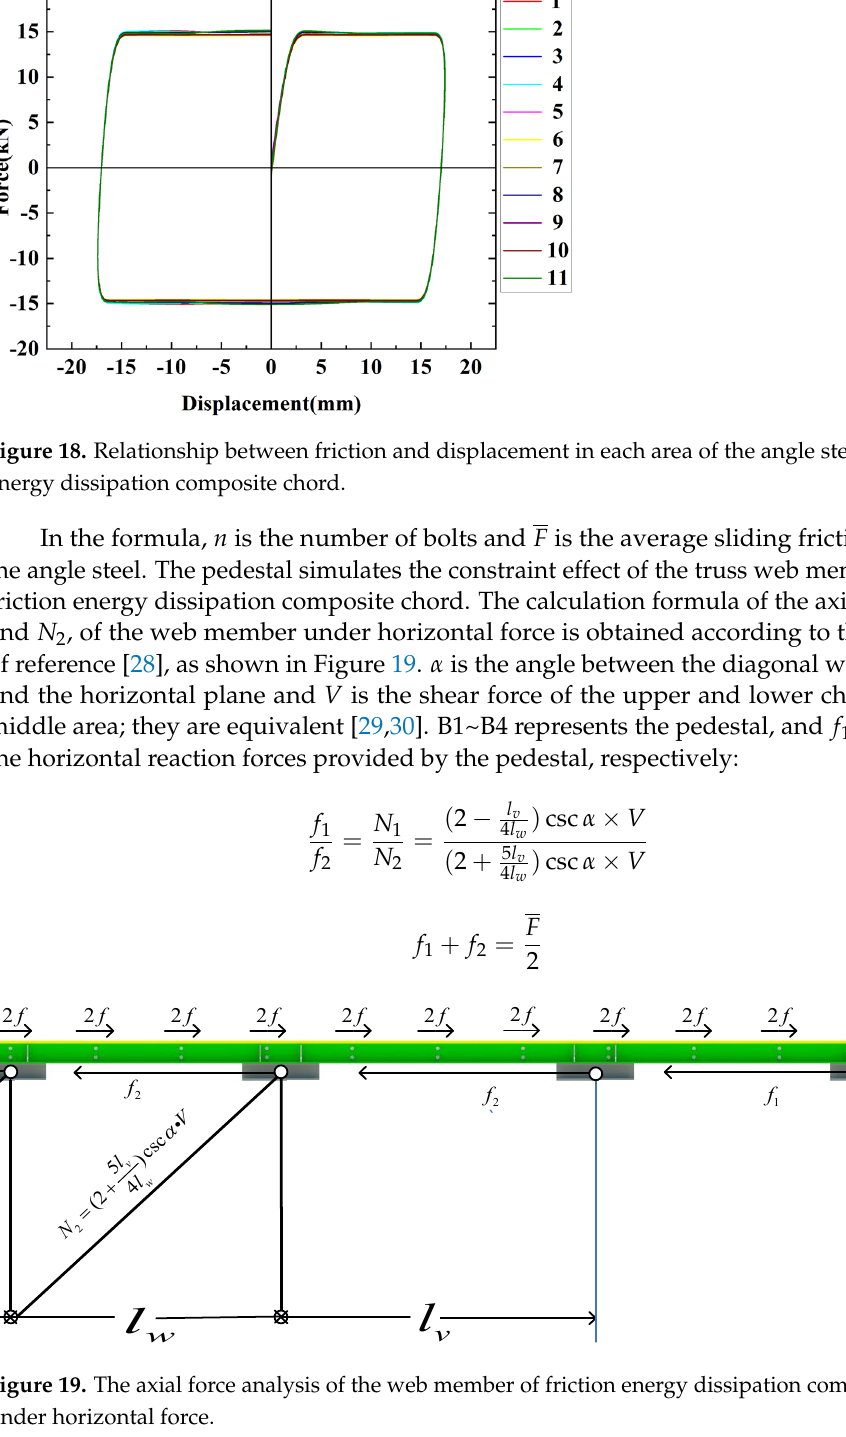
Figure 17. Area division of the angle steel of friction energy dissipation composite chord.